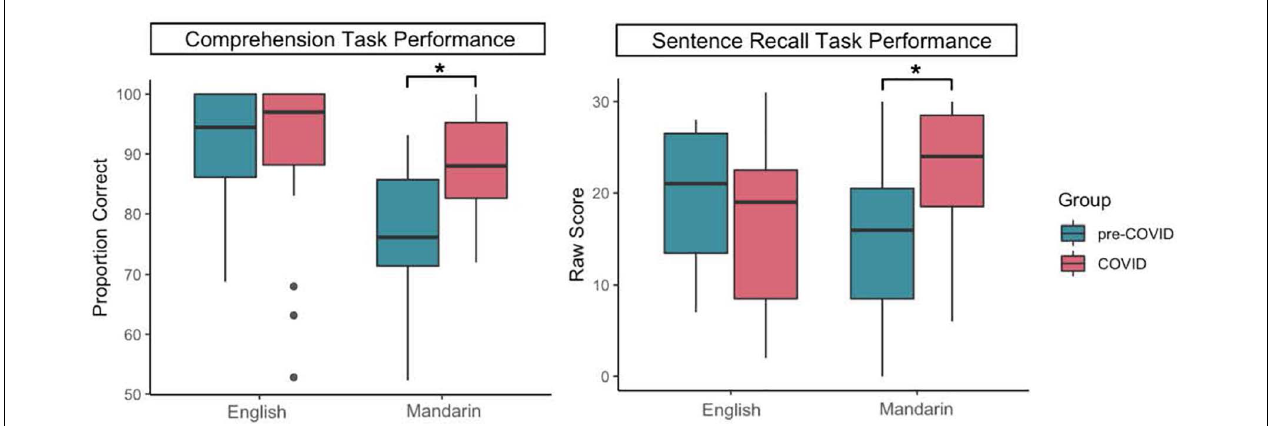
FIGURE 2 | Performance on the comprehension and the sentence recall task as a function of group and language.